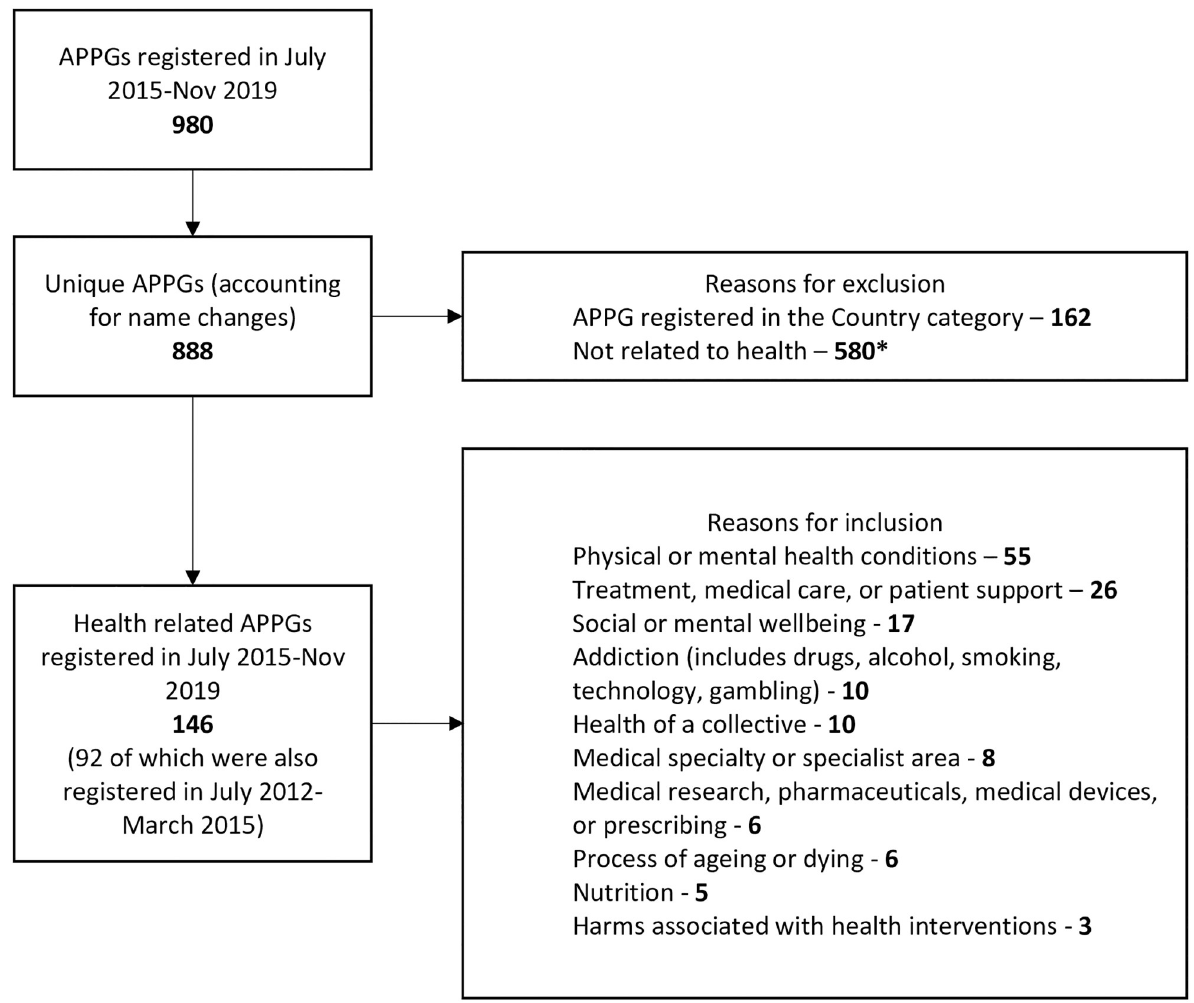
Fig 1. Identifying relevant APPGs. � Sport and other recreational activities (45), Faith, culture, or identity (40), Transport—airports, trains, roads (36), Finance or banking (29), Cities, regions, or places (27) Environment, conservation, or sustainability (24), Education—school, university, subjects (22), Energy, chemicals, oils or gases (22), Children or young people (20), Infrastructure, housing or property (19), Defence or security (18), Crime, corruption, or policing (17), Trade or Brexit (15), Equality, diversity, or human rights (13), Technology or media (13), TV, radio, or music (13), Business (12), Law (12), Parliamentary processes, government, or councils (11), Animals and animal welfare (10), International collaborations and relations or foreign affairs (10), Economic or social growth and development (9), People and society (9), Employment (8), Agriculture and farming (7), Art or other creative activities (7), Industries—manufacturing, engineering, manual labour (7), Charities or charitable work (6), Communities and societies (6), Democracy (6), Migration and immigration (6), Science, policy, or analysis (6), Water (6), Family (5), Food and drink —not health focused (5), Governance (5), Hospitality—e.g. catering, tourism (5), Public spaces or services (5), Retail and sales (5), Sexual or domestic violence (5), Alcohol (4), Industries—raw materials (4), Ports, ships, or sailing (4), Poverty (4), Publishing, design, printing, or writing (4), Safety or safeguarding (4), Beauty and fashion (3), Adoption or fostering (2), Events (2), History (2), Taxation